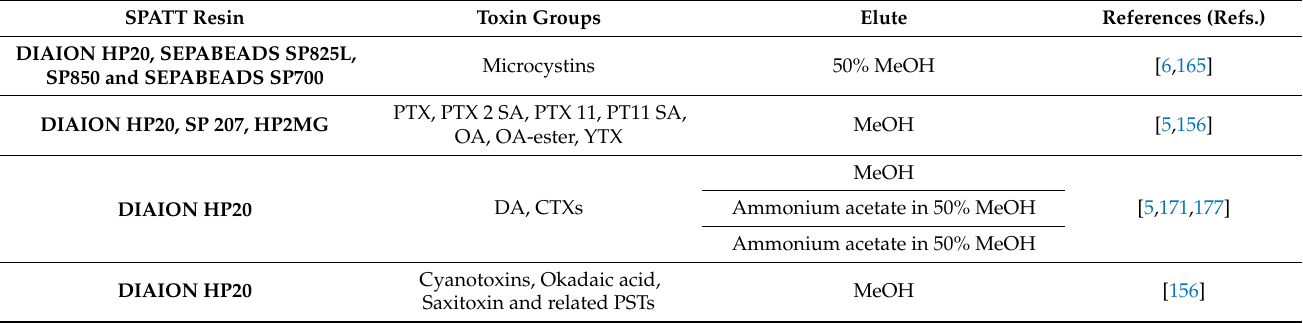
Table 3. Extraction steps for most common resins.